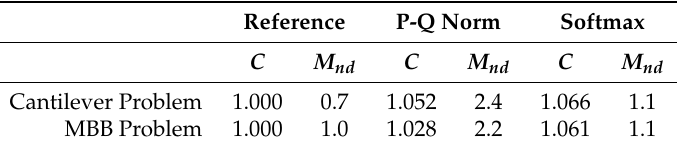
Figure 6. Comparison of the cantilever and MBB problems’ topology optimization with the original and modified fabrication models. Table 2. Overview of the cantilever and MBB problems’ topology optimization with the original and modified fabrication